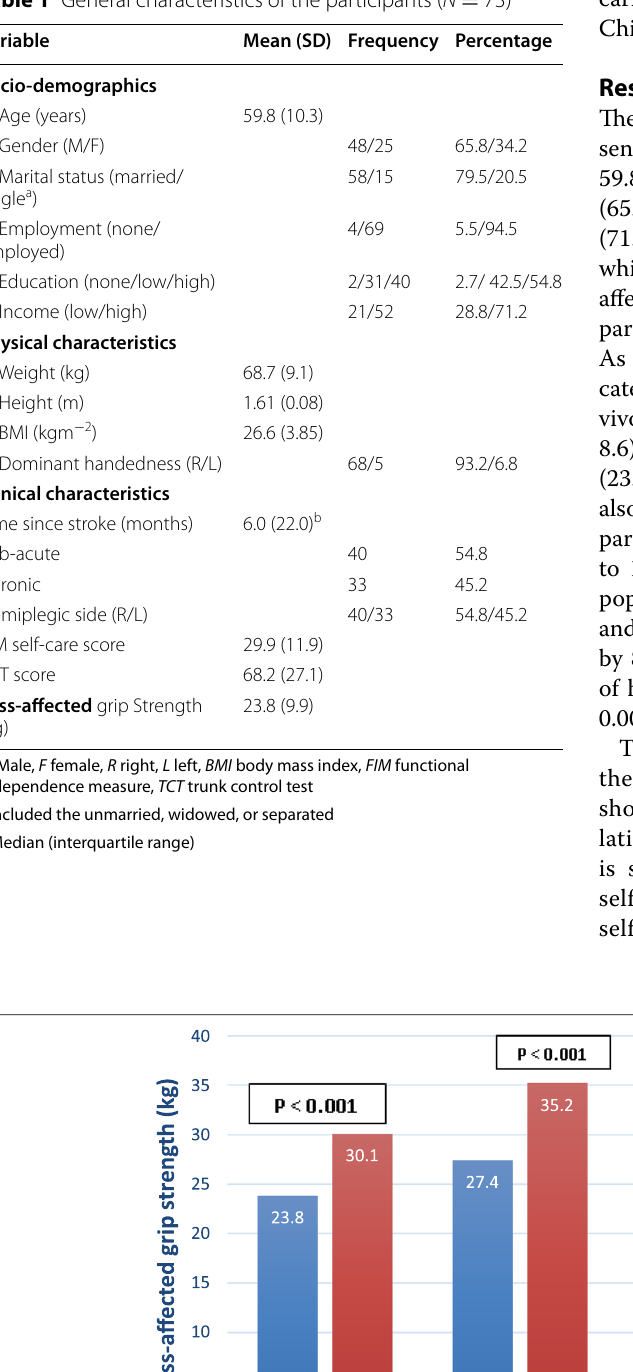
Table 1 General characteristics of the participants ( N